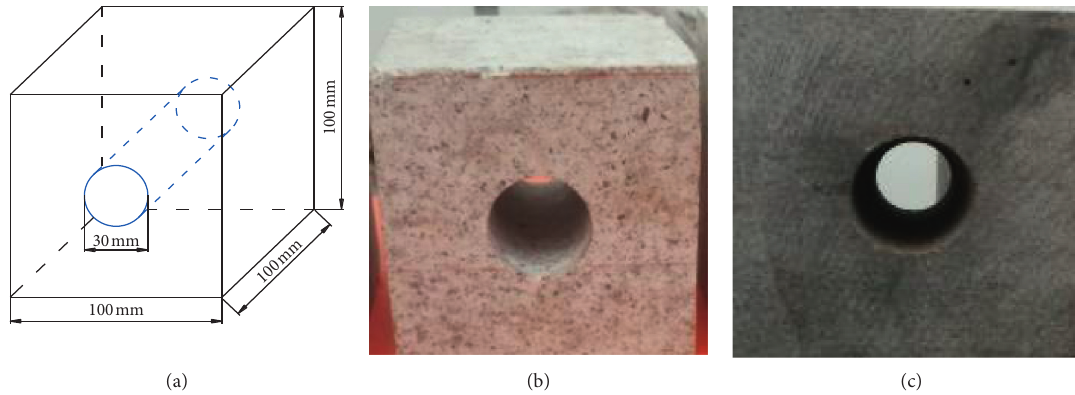
Figure 5: Cube sample used in the test. (a) Schematic diagram of the sample model. (b) Marble sample. (c) Sandstone sample.